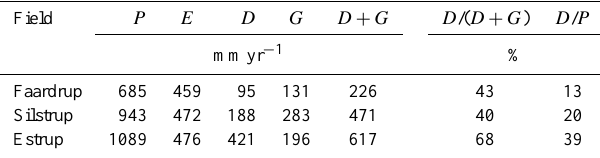
Table 1. Precipitation ( P ), evaporation ( E ), drainage ( D ), and groundwater discharge ( G ) for the agrohydrological year (June– June) for 2001–2012 for the Faardrup, Silstrup and Estrup fields.